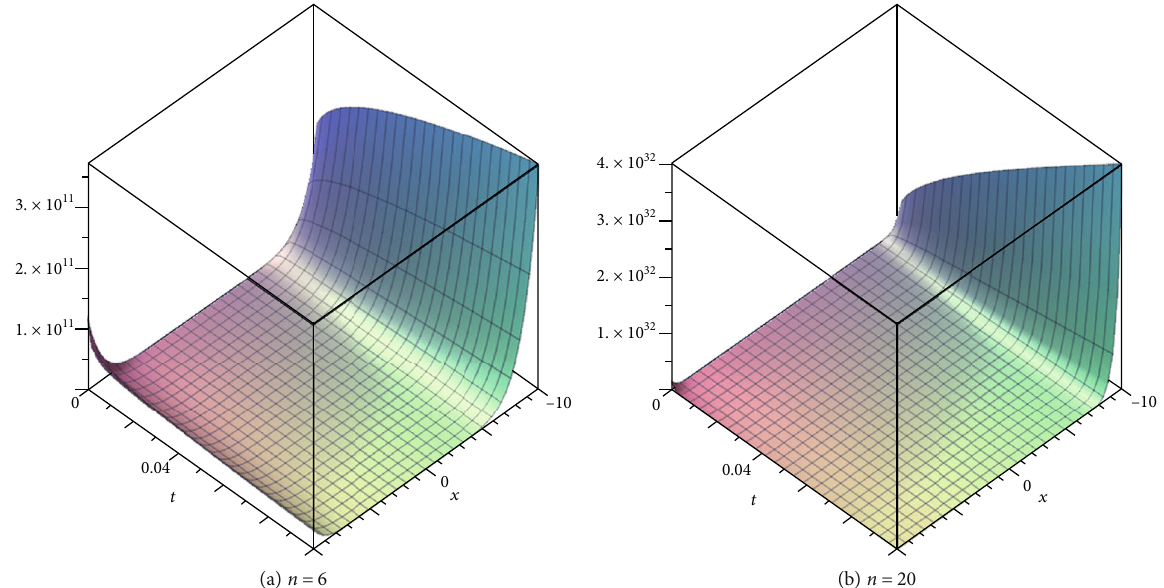
x , t Þ for Eq. (3) when a 2 ð